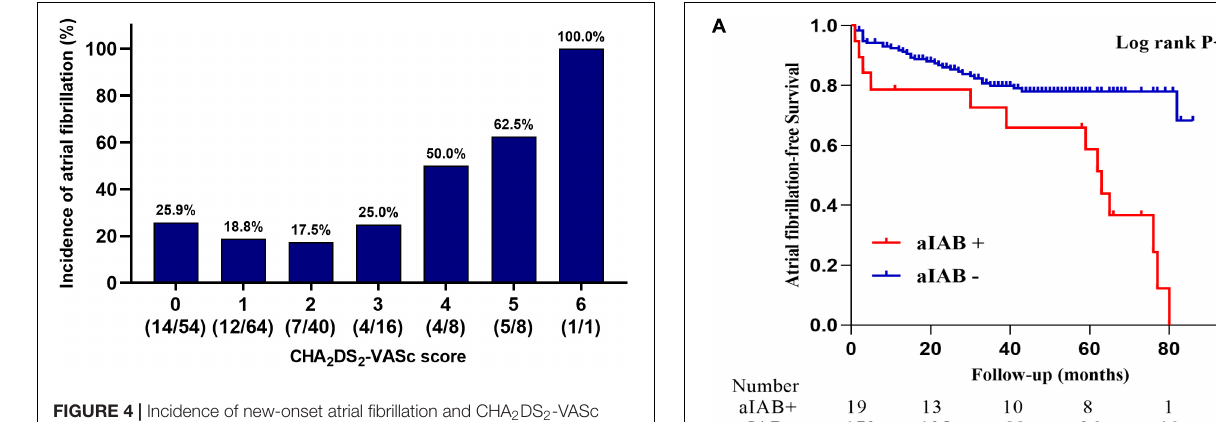
FIGURE 4 | Incidence of new-onset atrial fibrillation and CHA 2 DS 2 -VASc score. The incidence of new-onset AF increased with an increase of CHA 2 DS 2 -VASc score, especially in patients with CHA 2 DS 2 -VASc > 2 ( P = 0.046).